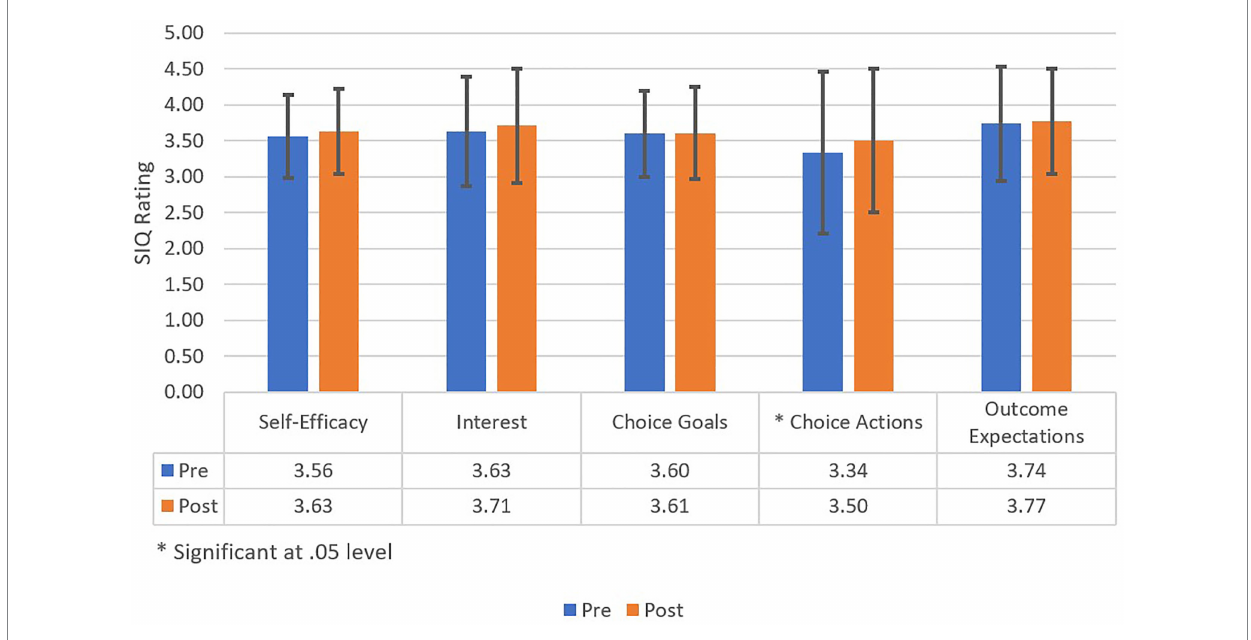
FIGURE 4 Aggregated pre- and post-SIQ ratings on each SIC-STEM